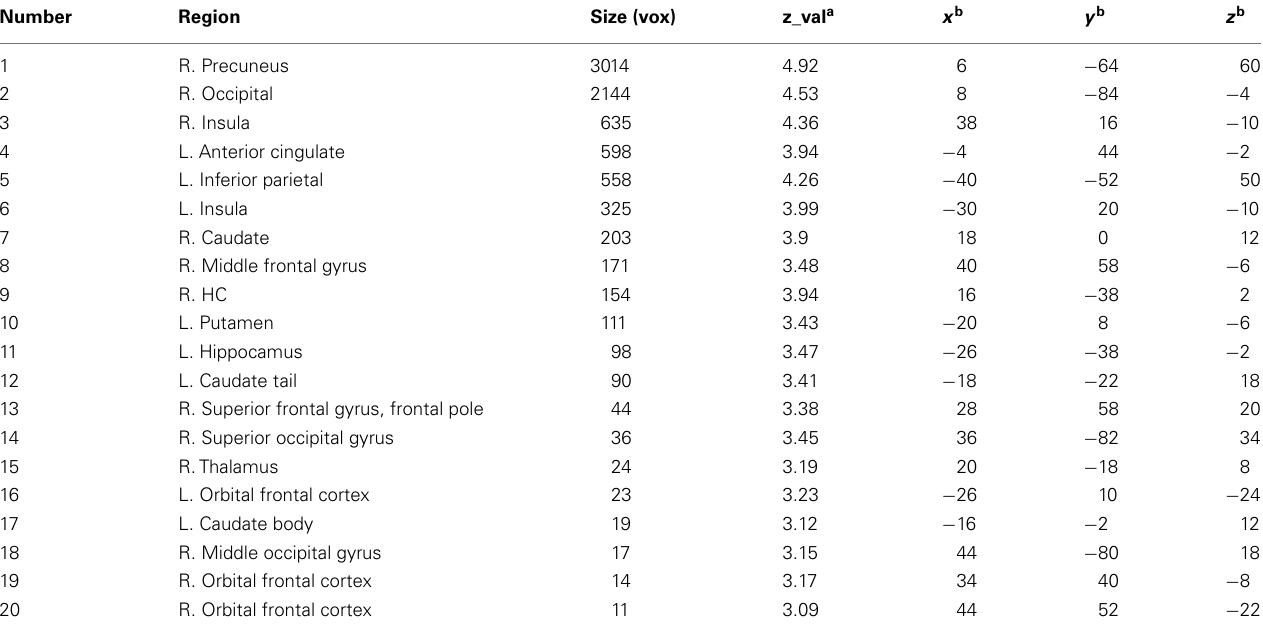
Table 2 |Whole-brain analysis linear effect of age group during